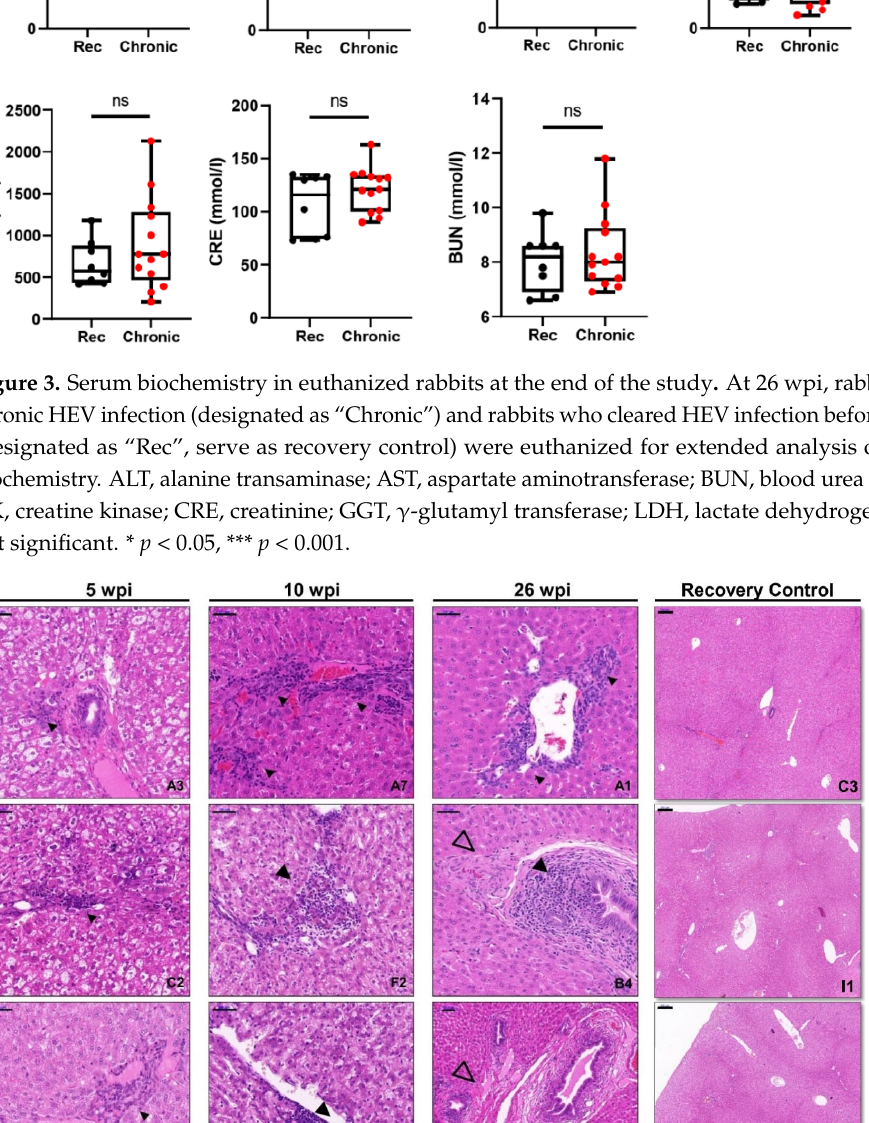
Figure 4. Dynamic of histopathology of liver tissue in HEV ‐ infected rabbits. The number of each rabbit was indicated on the lower right of each image. Liver tissues were collected from HEV ‐ infected rabbits at 5 ( A3 , C2 , D1 ),10( A7 , F2 , G1 ), 26 wpi ( A1 , B4 , F4 ) and from the recovery group( C3 , I1 , I4 ). Inflammatory cell infiltrates and hepatocyte necrosis were found (arrowhead) in all tissues and progressed as infection proceeded. At 26 wpi, chronic inflammatory cells infiltrate the portal area, blood vessel walls thickening associated with fibrosis (empty arrowhead) and local hyaline degeneration was found. No obvious lesion was found in the liver tissues of the recovery group. HEV, hepatitis E virus; wpi, weeks post-inoculation. Bars in the images of 5 wpi, 10 wpi and 26 wpi indicate 50 µ m. Bars in the images of recovery group indicate 200 µ